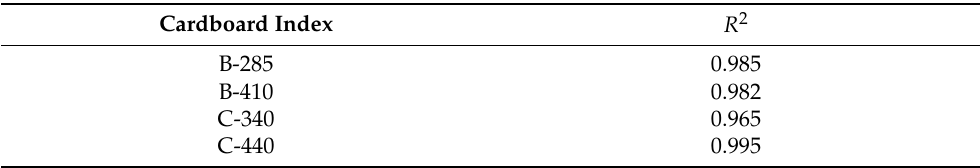
Figure 15. The decreases in normalized ECT and THK2 values for corrugated board with an index: ( a ) B ‐ 285; ( b ) B ‐ 410; ( c ) C ‐ 340 and ( d ) C ‐ 440. For the reference line and normalized ECT and THK2 values, the coefficients of determination R 2 were computed (Table 5), according to Equation (1) for the two sets of data simultaneously, where: x i —reference line value calculated from the Equation (5), ˆ y i —normalized ECT and THK2 values and var ( x ) —variance of the reference line value. Table 5. The coefficient of determination R 2 between reference line and normalized ECT and THK2 values.